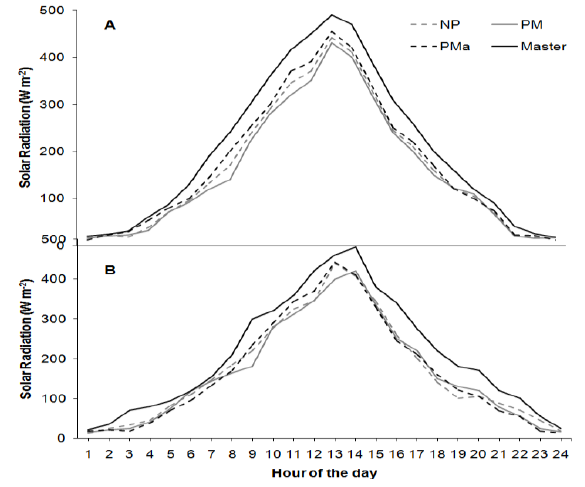
Figure 6. Daily cycle of solar radiation (W·m −2 ) at the two vineyards ( A ) (Ponte Piave) and ( B ) (San Nicolò) in the three field treatments applied: NP, no pruning (gray dotted line); PM mechanical pruning (gray solid line); PMa manual pruning (black dotted line). Master (black solid line) is the solar radiation measured outside the vineyard. All the values are hourly averages of two years of observations from April to September.